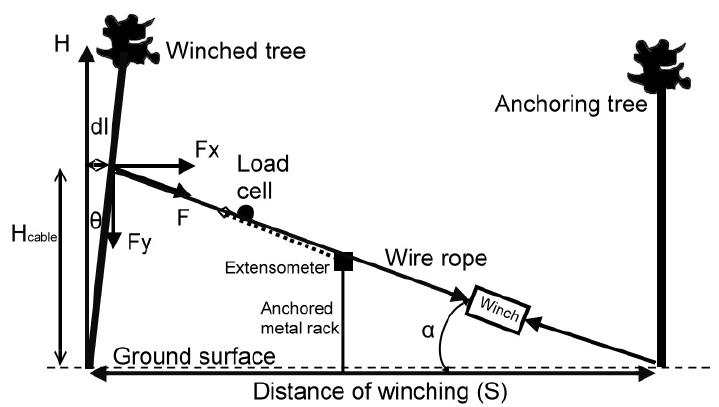
Figure 1. Schematic diagram of the setup of the winching tests (redrawn from [5]).